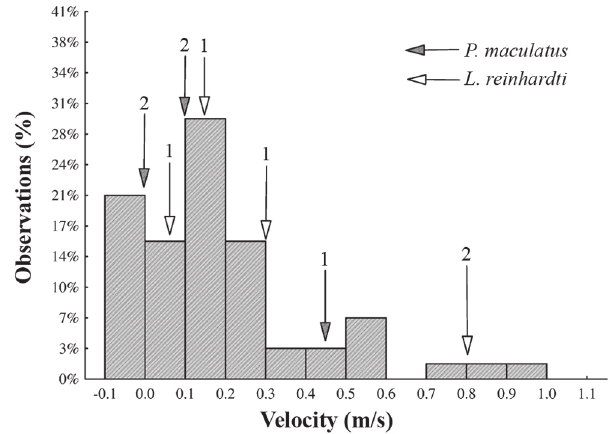
Fig. 4. The distribution of flow velocities in pool 2.